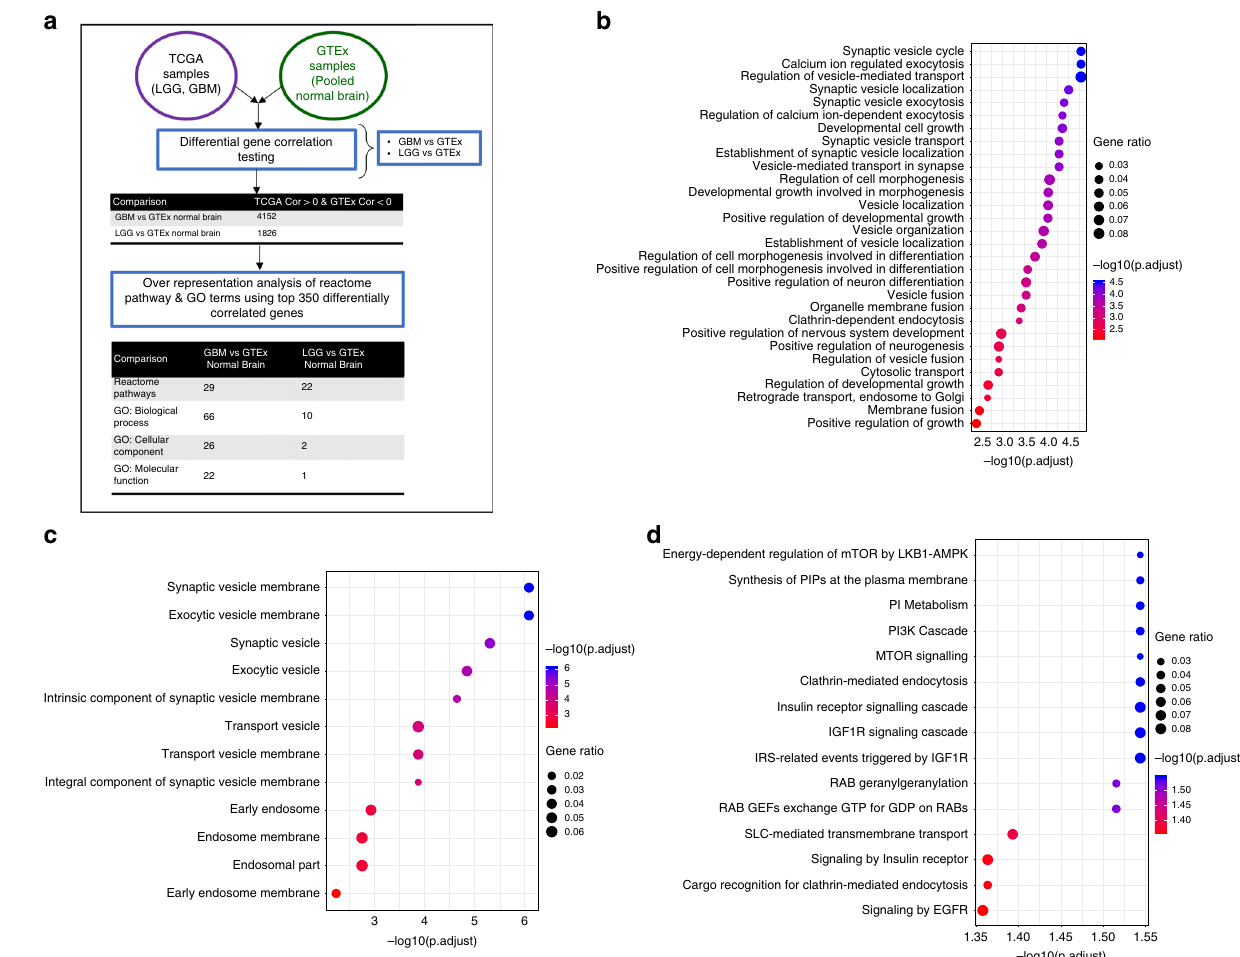
Fig. 3 GO enrichment analysis for NTRK2 in GBM or LGG. a Schematic of DGCA analysis for the top 350 genes signi fi cantly positively correlated with NTRK2 in LGG or GBM. GO terms for biological processes in top 350 differentially expressed genes in GBM compared with normal brain ( b ) and GO terms for the top 350 differentially expressed genes in the cellular component in GBM compared with normal brain ( c ) revealed a predominance of genes implicated in morphogenesis and proliferation, as well endocytic compartments and vesicular transport. d Gene ontology enrichment terms for the genesets within the reactome pathways in top 350 differentially expressed genes in LGG compared with normal